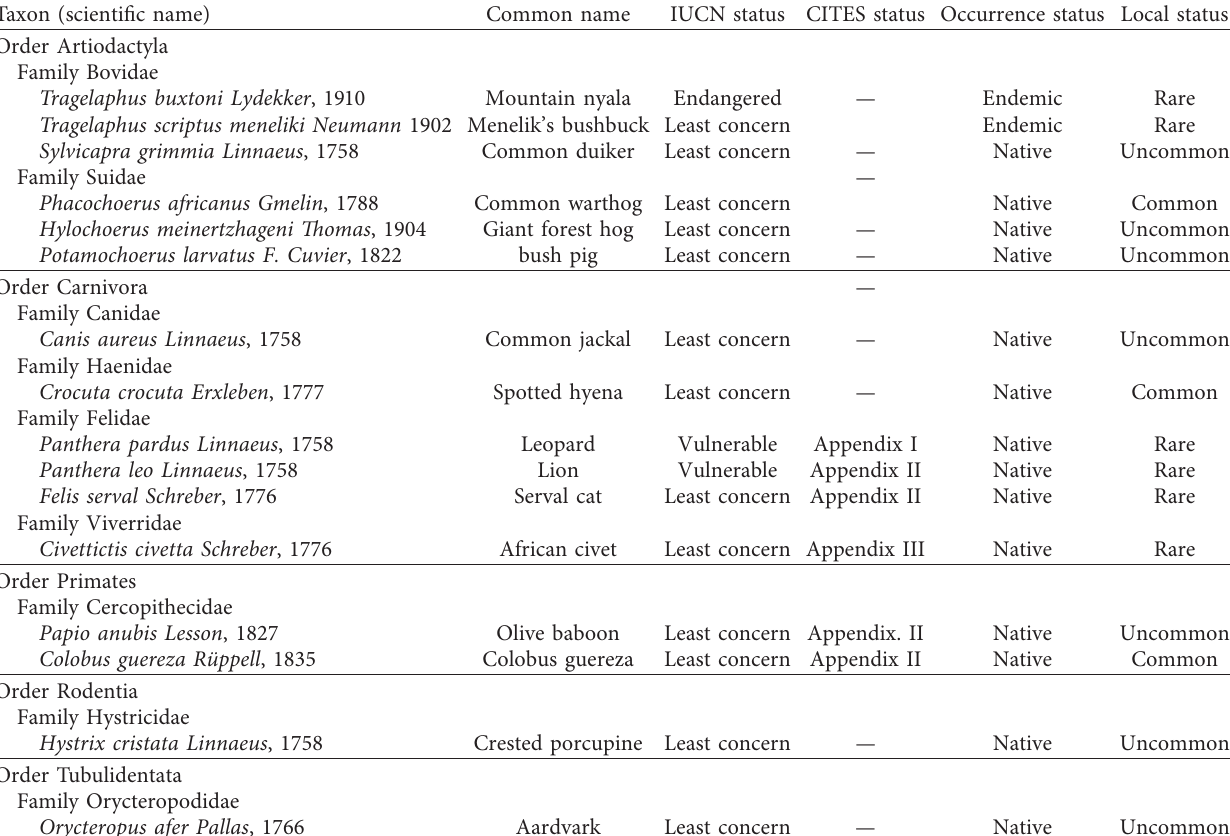
Table 1: Large mammal species composition and their conservation status at Nensebo forest, Southern Ethiopia.